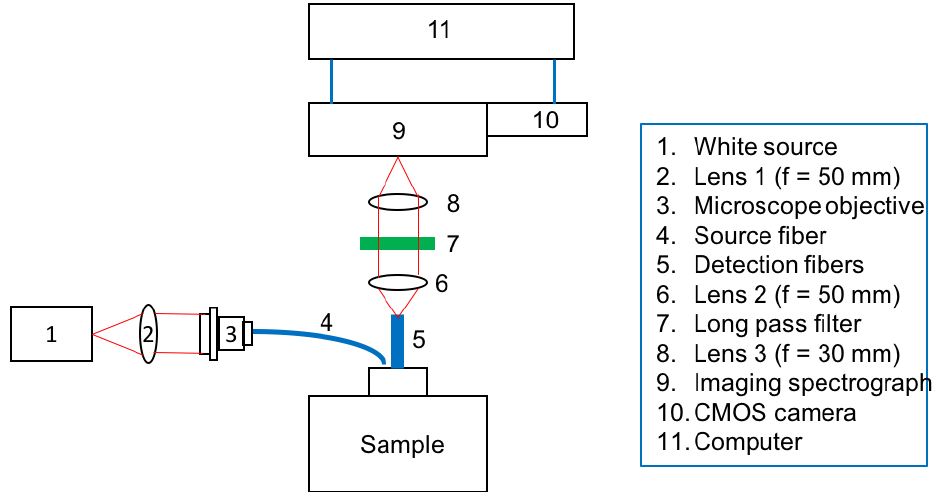
Figure 1. Schematic diagram of the experimental system.